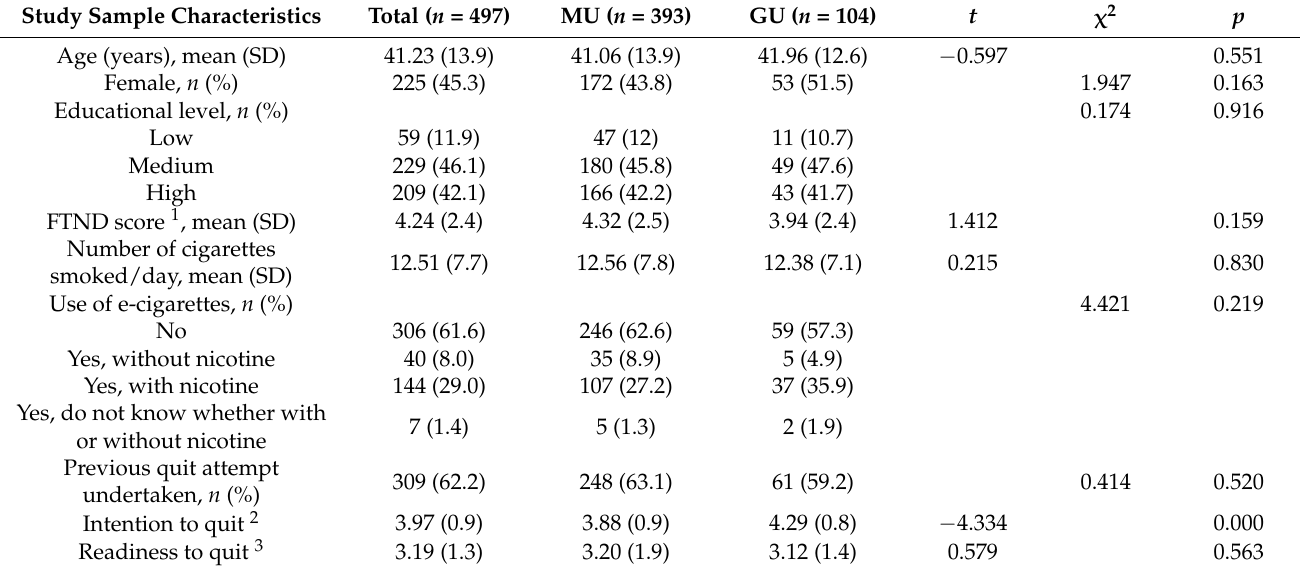
Table 2. Characteristics of the sample including smoking